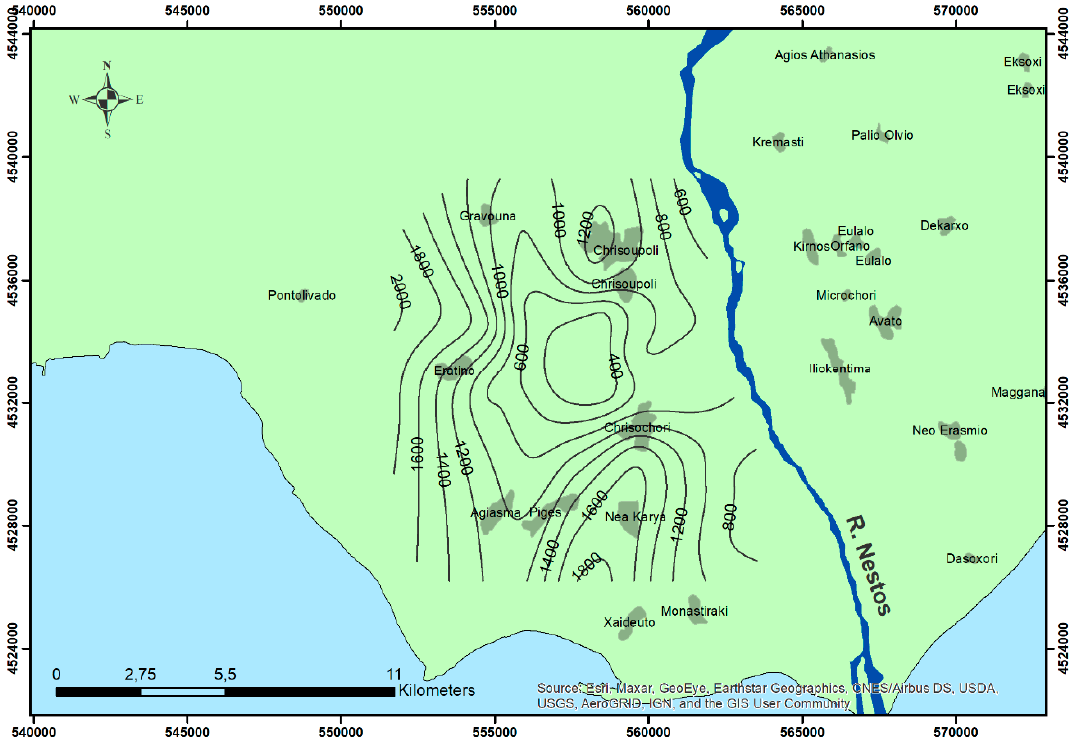
Figure 9. Electrical conductivity distribution map ( μ S/cm) of the unconfined aquifer (May 2019).